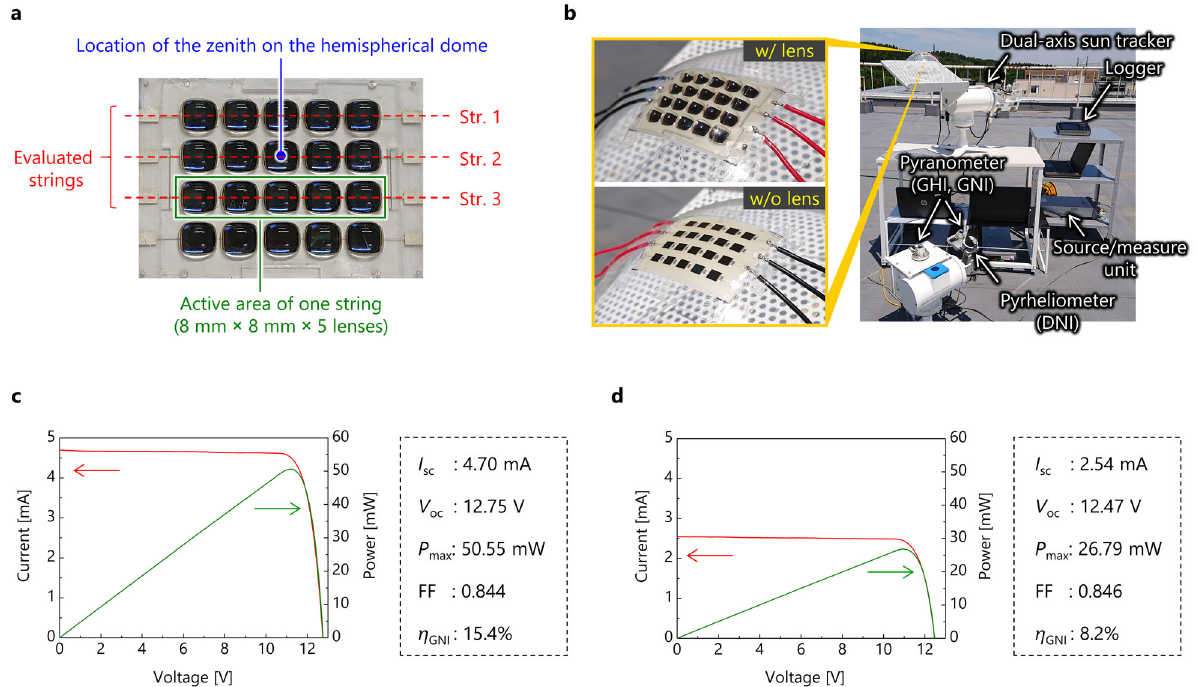
Fig. 3 Outdoor investigation of fundamental I – V characteristics. a The three evaluated strings and the cell-lens positioned at the zenith on the hemispherical dome during the outdoor tests. b Photograph of the experimental setup for the outdoor instantaneous measurement of I – V characteristics. c , d I – V curves of string 2 (center string) under a clear-sky condition, w/ and w/o lens, respectively (global normal irradiance: GNI = 1025 ± 1 W m − 2 , direct normal irradiance: DNI = 868 ± 1 W m − 2 ). I sc, V oc , P max , FF, and η GNI are short-circuit current, open-circuit voltage, generated power, fi ll factor, and GNI- based module conversion ef fi ciency, respectively. η GNI was calculated as the ratio of P max per active module area (one string: 8 mm × 8 mm × 5 lenses) to GNI. (w/ lens, with lens; w/o lens, without measured. Figure 3c, d shows the I – V curves of string 2 (center string) under a clear-sky condition with and without lens, respectively. When the prototype module was fi tted on the spherical surface, the outline of the active module area shown in Fig. 1d (i.e., 32 mm × 40 mm) was elongated by ~1 mm in directions both parallel and orthogonal to the string directions, which corresponds to ~3% strain and is smaller than 1/3 of the